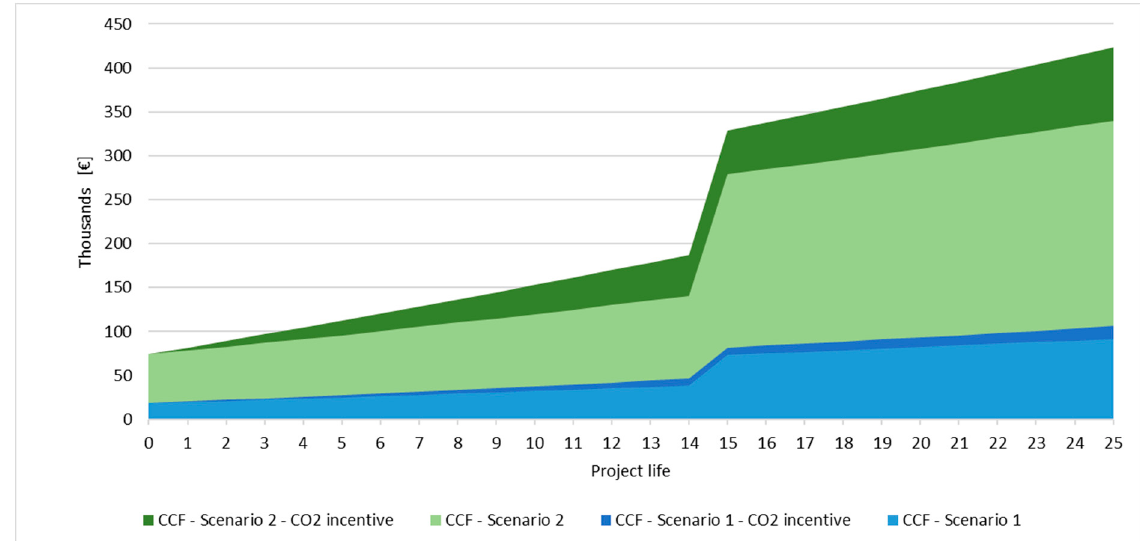
Figure 6. Cumulative cash flow (CCF) for Scenario 1 and 2.